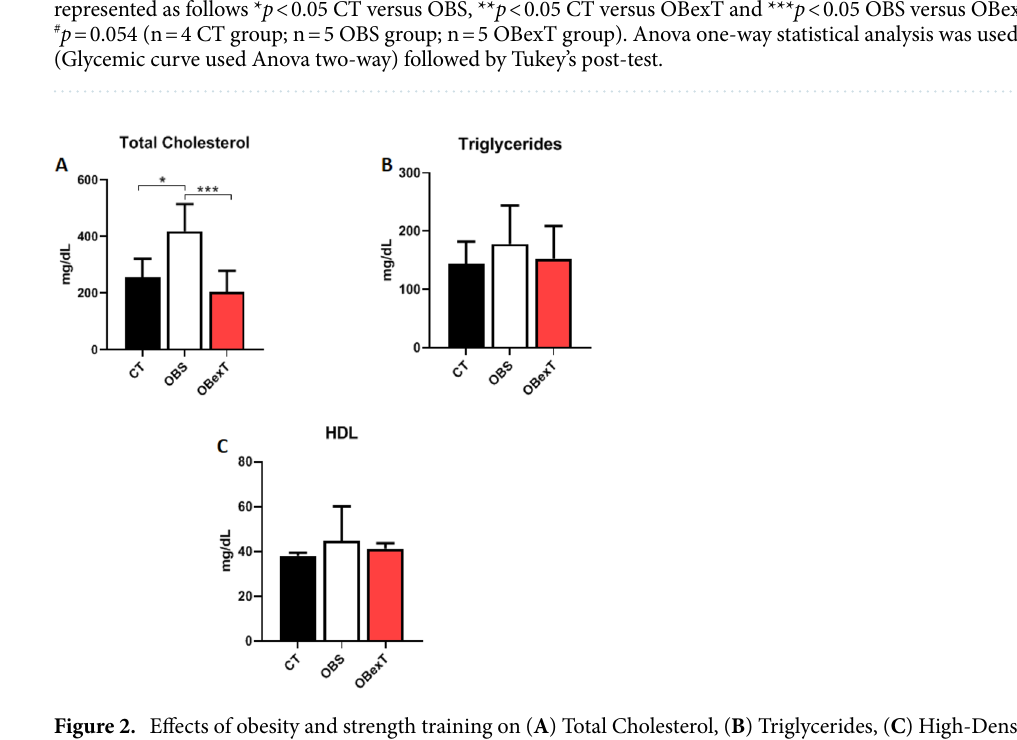
Figure 2. Effects of obesity and strength training on ( A ) Total Cholesterol, ( B ) Triglycerides, ( C ) High-Density Lipoproteins (HDL). The signal of statistical difference are represented as follows * p < 0.05 CT versus OBS, ** p < 0.05 CT versus OBexT and *** p < 0.05 OBS versus OBexT (n = 5 CT group; n = 6 OBS group; n = 6 OBexT group). One-way Anova statistical analysis was used, followed by Bonferroni